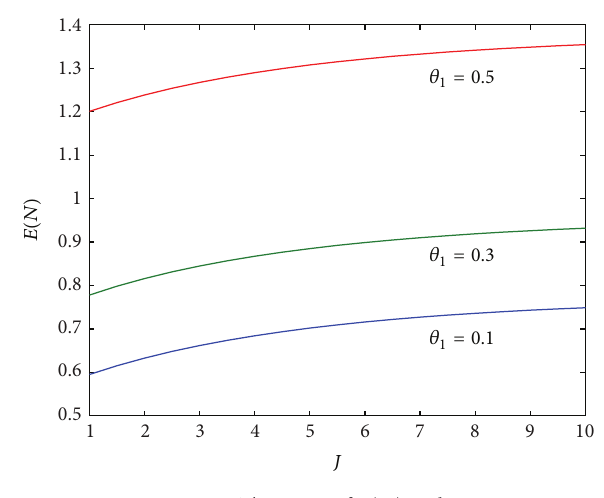
Figure 3: The curve of 𝐸(𝑁) with 𝐽 .